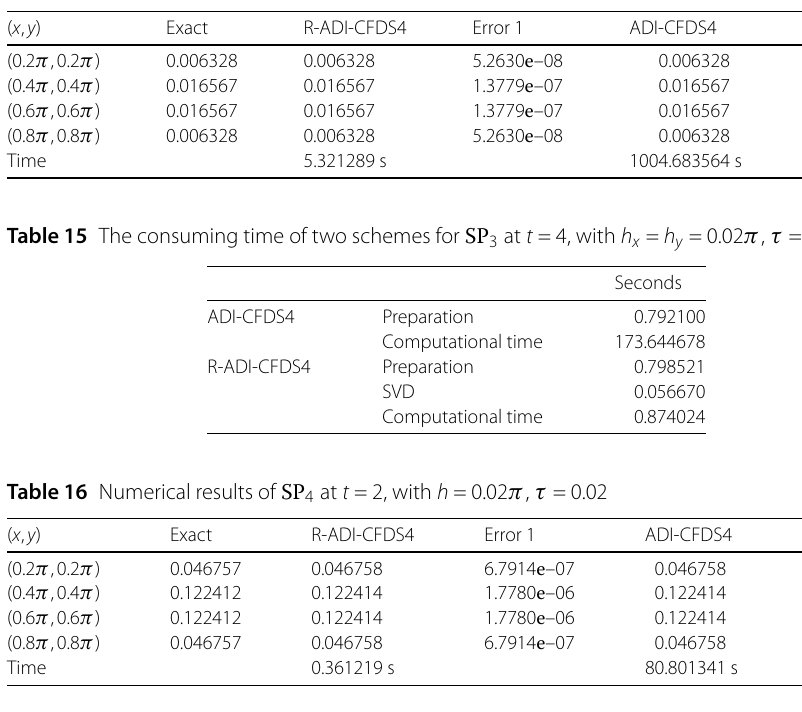
Table 17 Numerical results of SP 4 at t = 2, with h = 0.01 π , τ = 0.005 ( x , y ) Exact R-ADI-CFDS4 Error 1 ADI-CFDS4 Error 2 (0.2 π ,0.2 π )